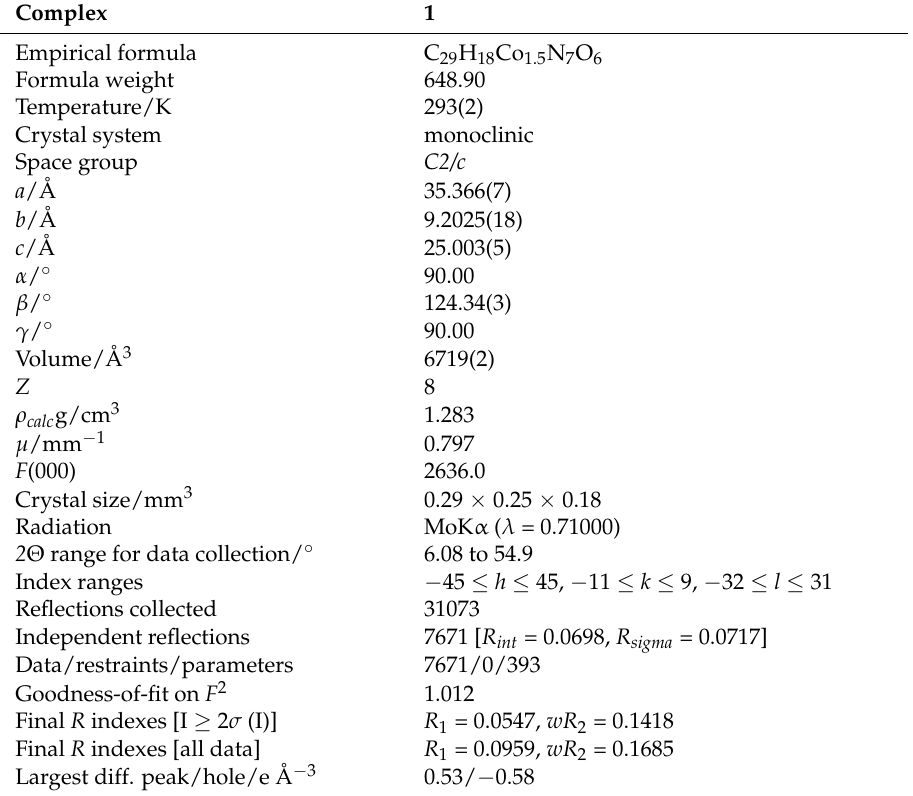
Table 1. Crystal data and structure refinement for 1 .